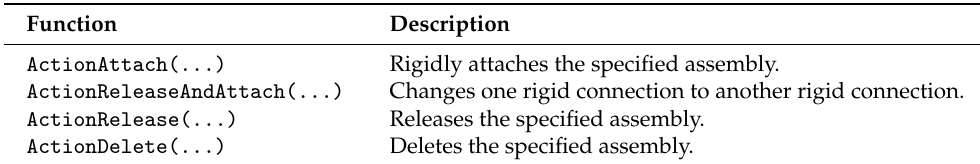
Table 2. Modia3D actions that trigger a full restart for a structural change. For applications, see Section 6.